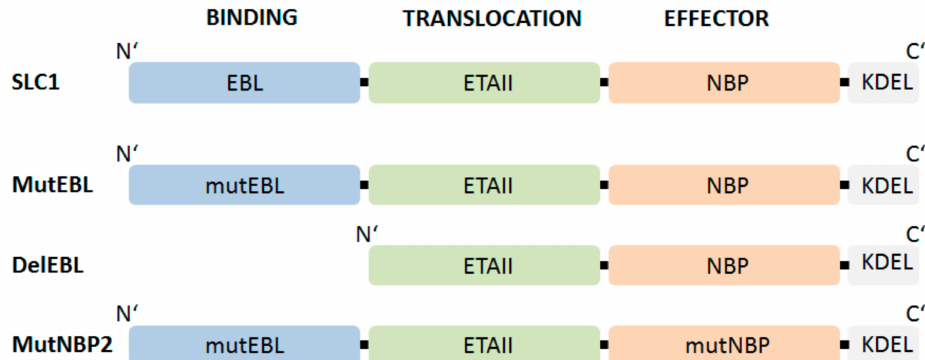
Figure 5. Schematic representation of functional and non-functional SLFPs to investigate E-selectin specific-NF-kappaB inhibition. SLC1 consists of an E-selectin binding motif named